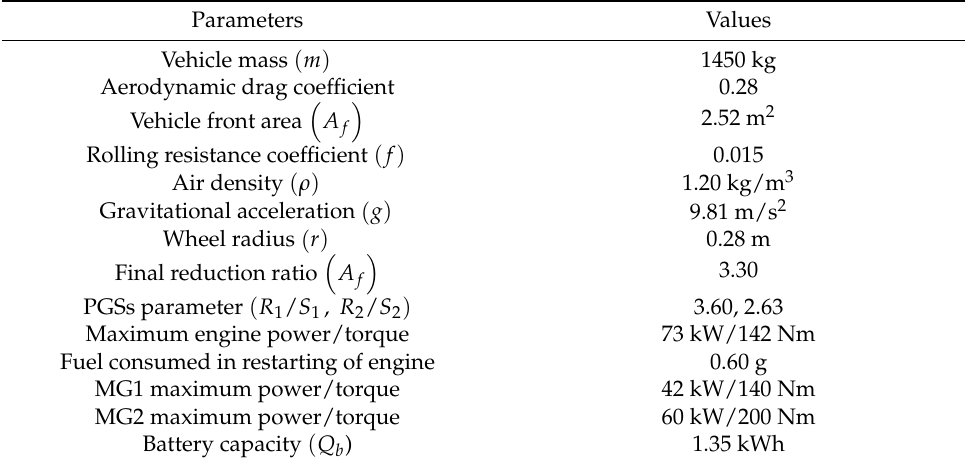
Table 3. Power-split HEV Prius 2013 parameters.